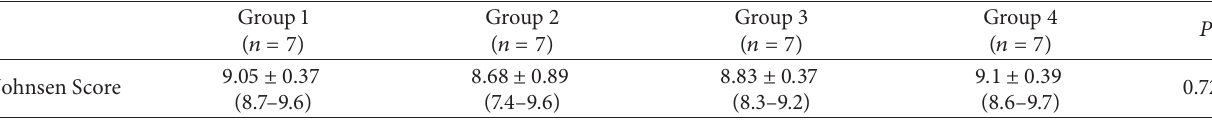
Table 4: Johnsen Scores and the statistical analysis